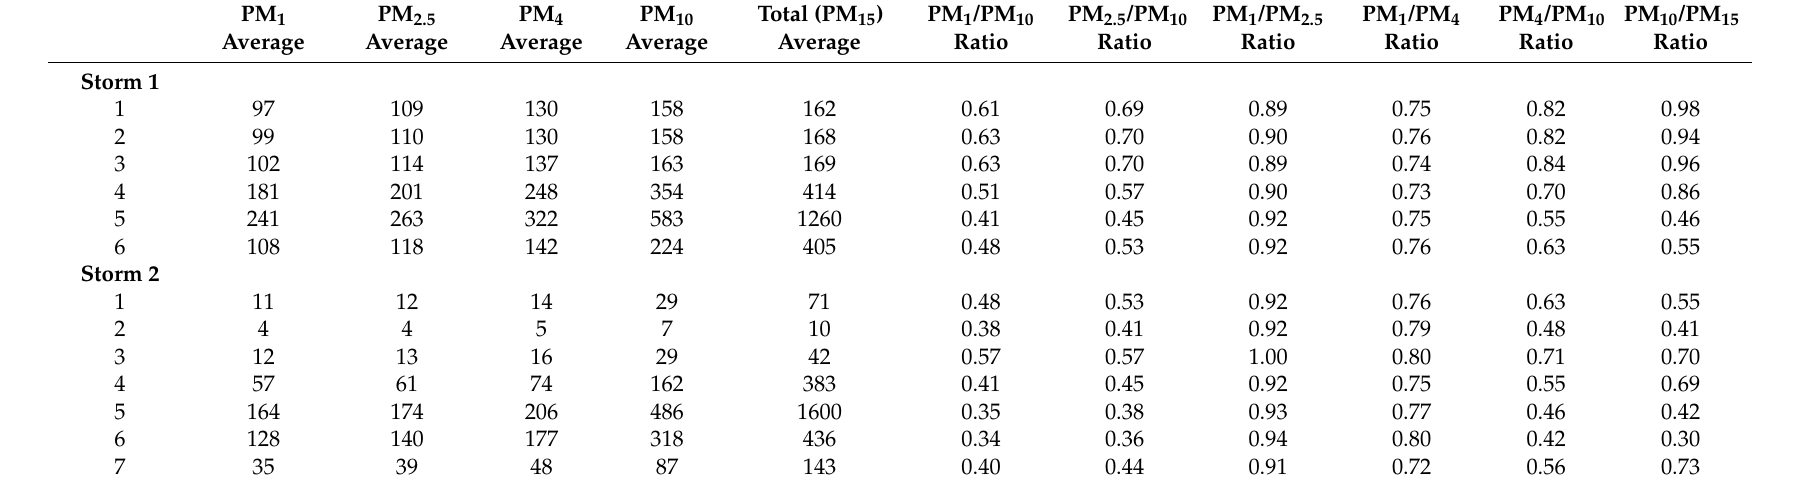
Table 1. Particulate matter concentrations PM 1–15 ( µ g ¨ m ´ 3 ) for both storms. Ratios between different PM values are